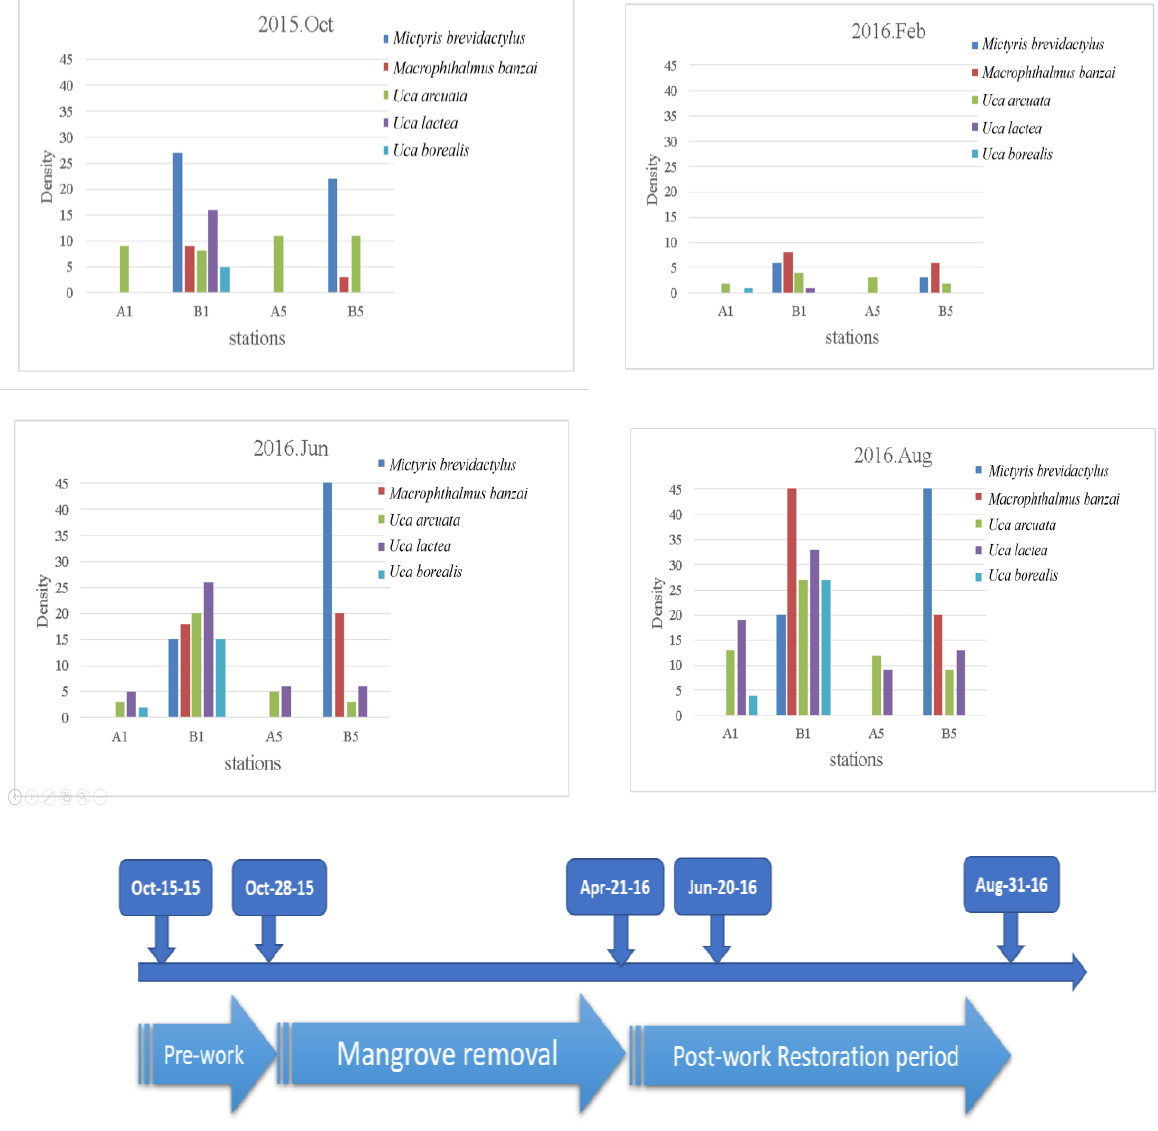
Figure 7. Densities of five indicator species at four sites, A1, B1, A5, and B5, in October 2015 and February, June, and August 2016.